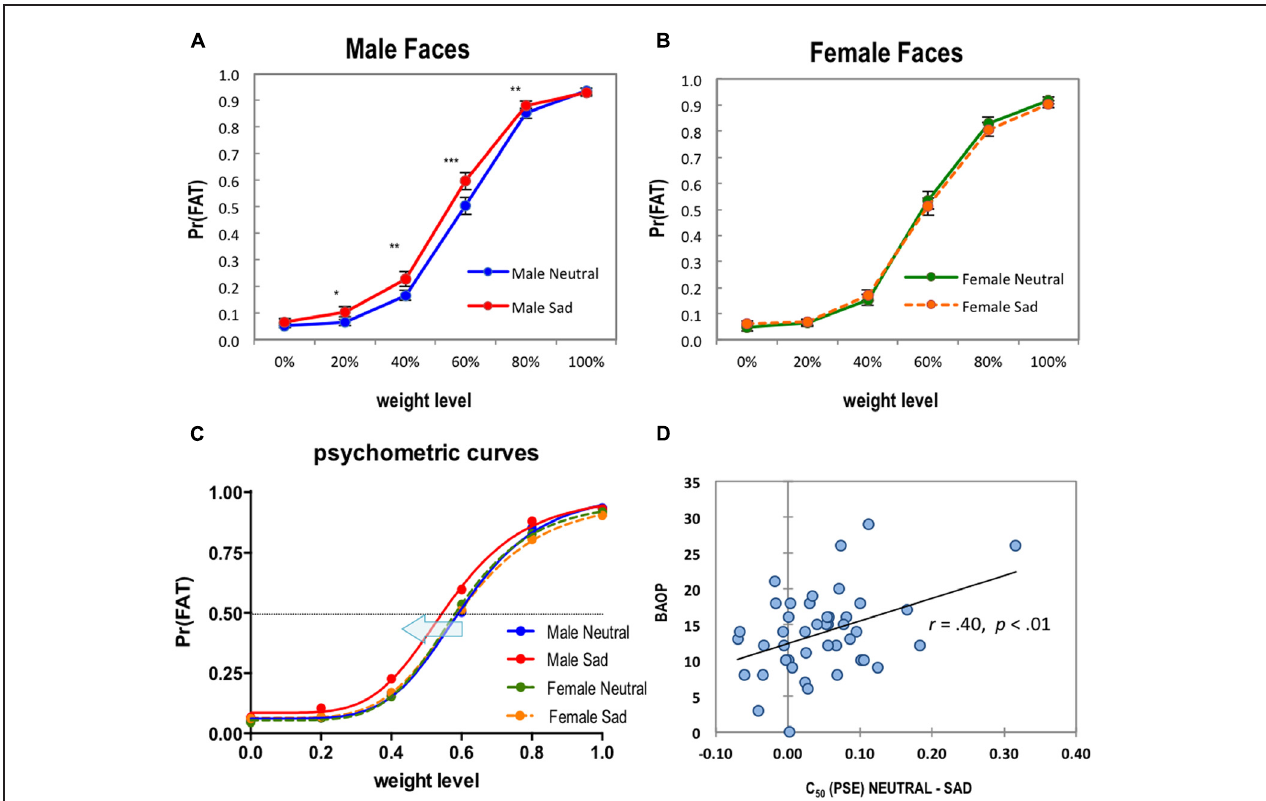
FIGURE 2 | (A) Male face data. (B) Female face data. Average probability of fat responses as a function of weight levels (0–100% overweight) and emotional expressions. Error bars denote the SE of the mean. ∗ p < 0.01; ∗∗ p < 0.005; ∗∗∗ p < 0.001. (C) For the weight judgment data, psychometric curves were fitted by using the Naka-Rushton response function. A leftward-shift of a psychometric curve of Male Sad faces (red line) compared